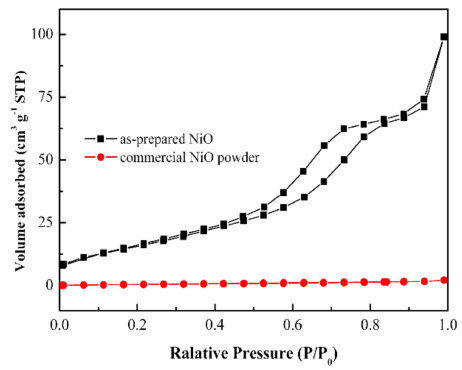
Figure 2. Nitrogen sorption isotherms of the as-prepared NiO and commercial NiO powder.